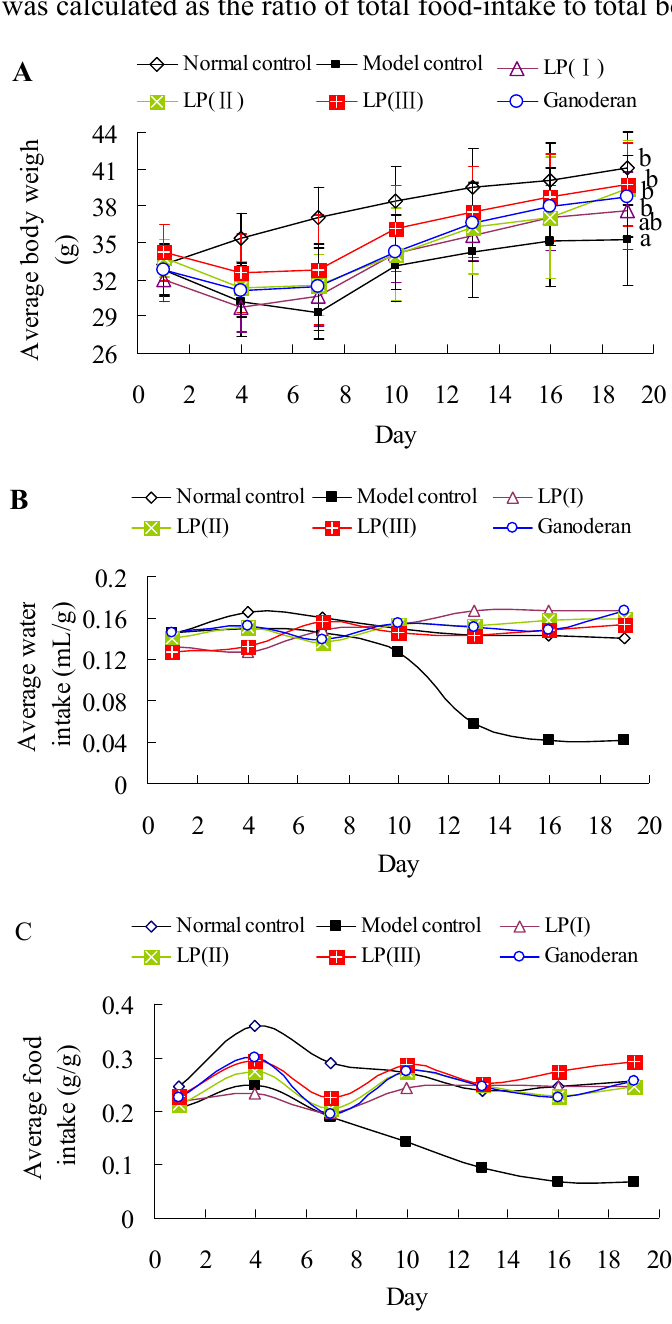
Figure 4. Effects of LP on the bodyweight ( A ); water-intake ( B ); and food-intake ( C ) of immunosuppressed mice. The average bodyweight of each group was expressed as means ± standard deviation (n = 10). The significant differences among the groups were evaluated with ANOVA followed by the S-N-K test. Data points with different letters in figure A are significantly different ( P < 0.05). Average water-intake (mL/g) was calculated as the ratio of total water-intake to total body weight in each group, and average food-intake (g/g) was calculated as the ratio of total food-intake to total body